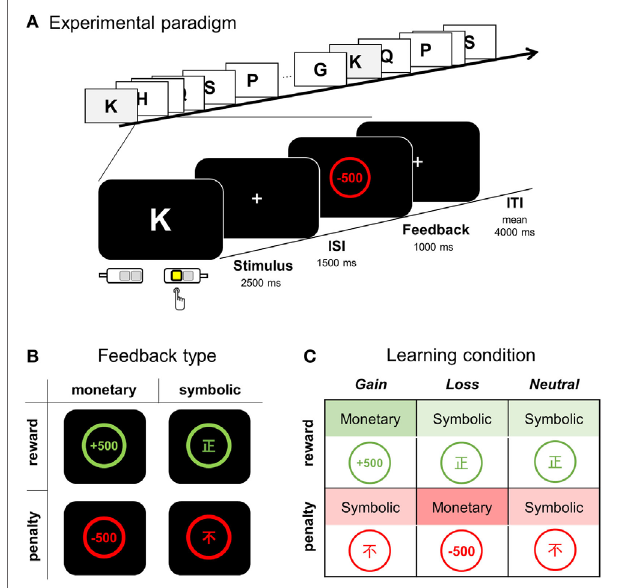
FigUre 1 | Overview of the feedback type and experimental paradigm. (a) During a visuomotor association task, a participant was instructed to learn appropriate S-R association pairs by pressing one of four response keys while a single letter stimulus was presented for 2,500 ms and followed either by positive or negative feedback for correct and error responses, respectively. (B) Four types of feedback: monetary reward, symbolic reward, monetary penalty, and symbolic penalty. (c) Three types of learning condition according to the feedback contingency. ISI, inter-stimulus interval; ITI, inter-trial